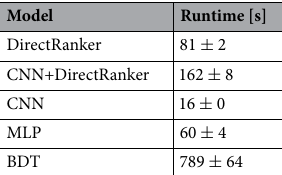
Table 3. Mean training time of the different models evaluated on fivefolds of the balanced data